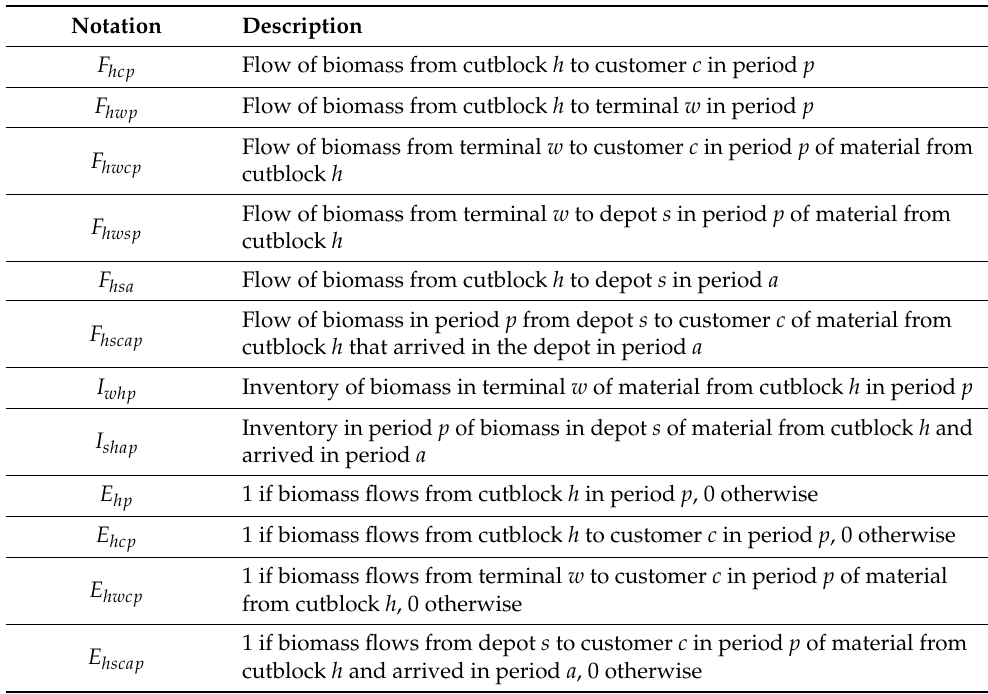
Table 3. Decision variables of the mixed-integer programming